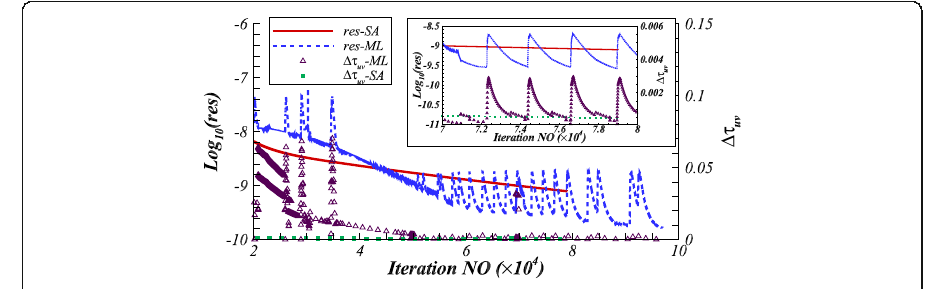
Fig. 18 The residual evolution for case C6 of NACA0012 airfoil